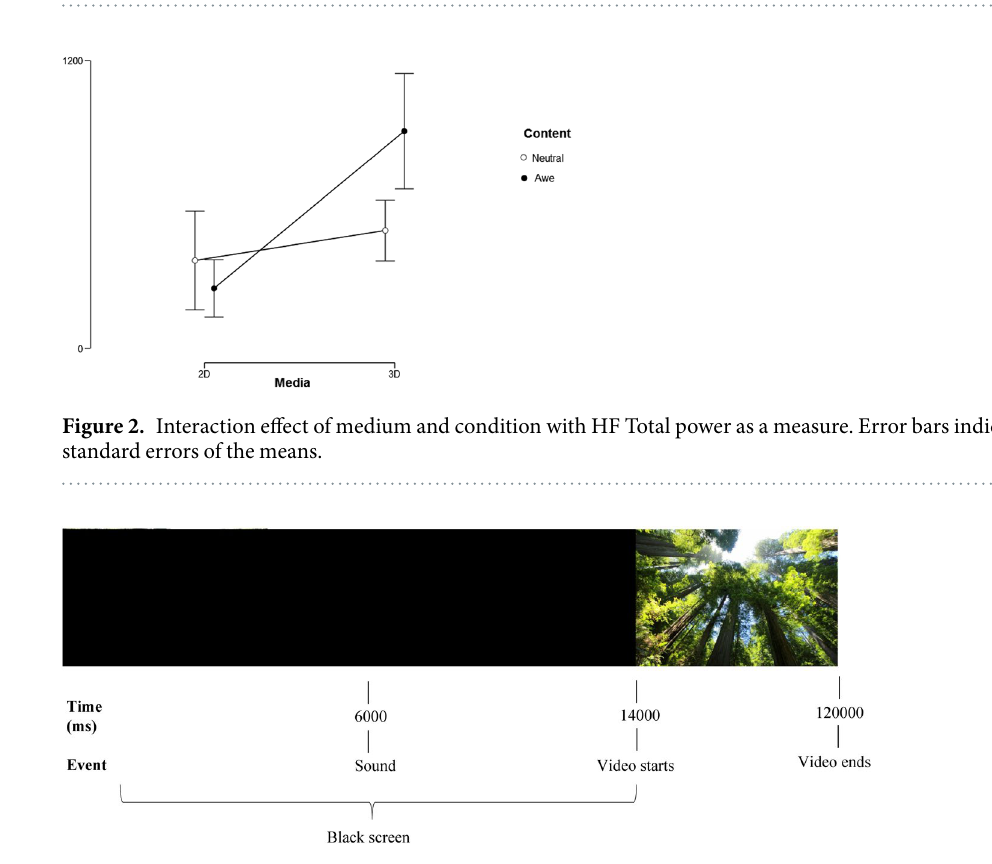
Figure 1. Interaction effect of media and content with awe as a measure. Error bars indicate standard errors of the means.